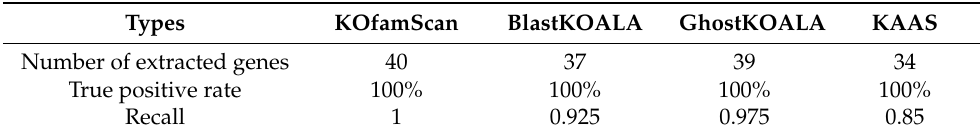
Table 1. Performance of the KEGG_Extractor based on different KEGG